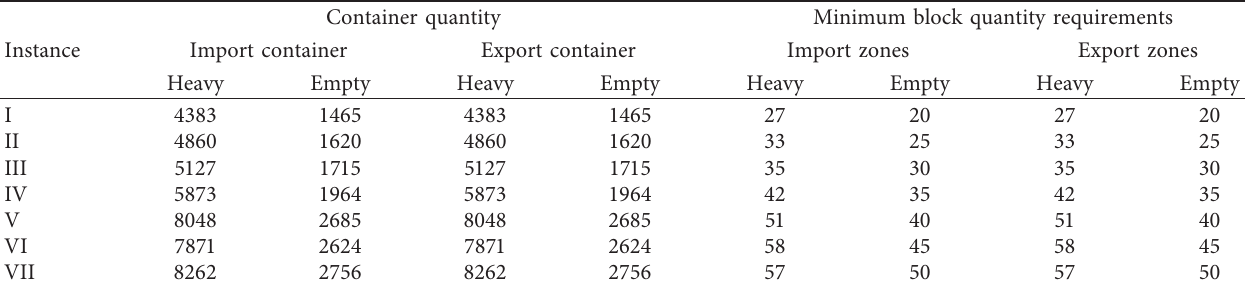
Table 2: The container number and minimum block quantity requirement of each